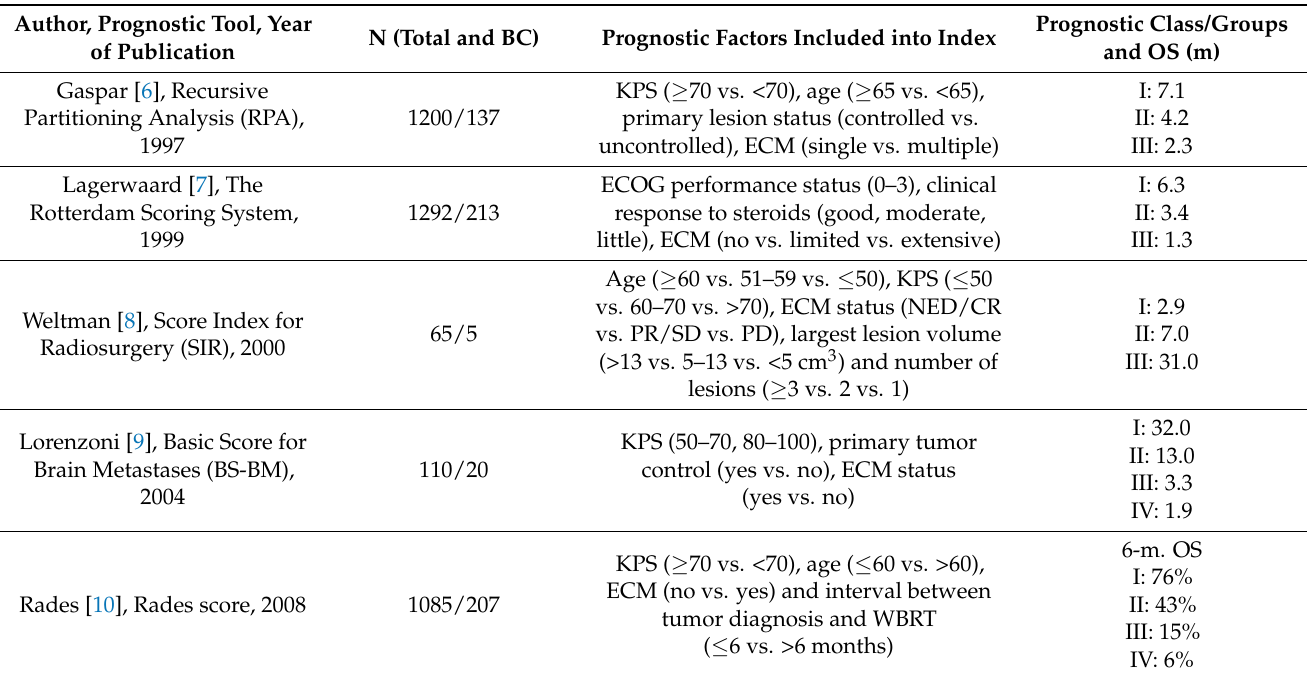
Table 1. Prognostic tools developed on mixed groups of patients with BM (from year 1997 to